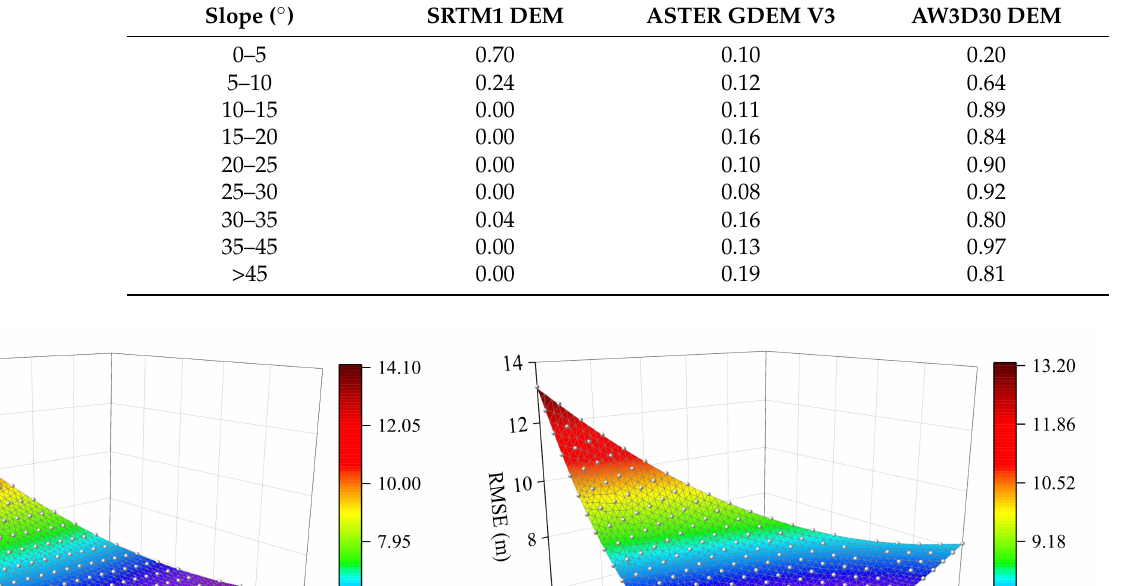
Table 2. The coefficient of DEM weighted average.